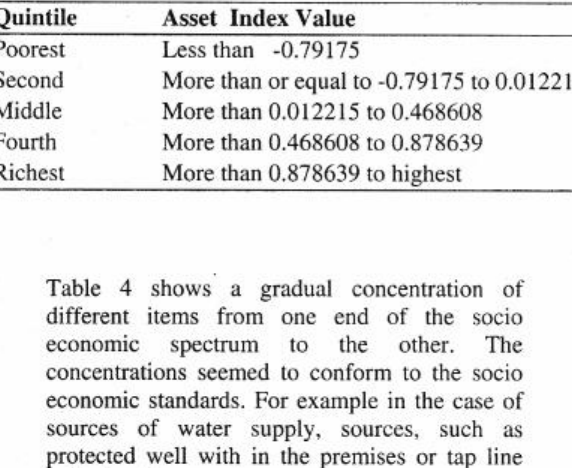
Table 3. Quintile cutoff points of the socio